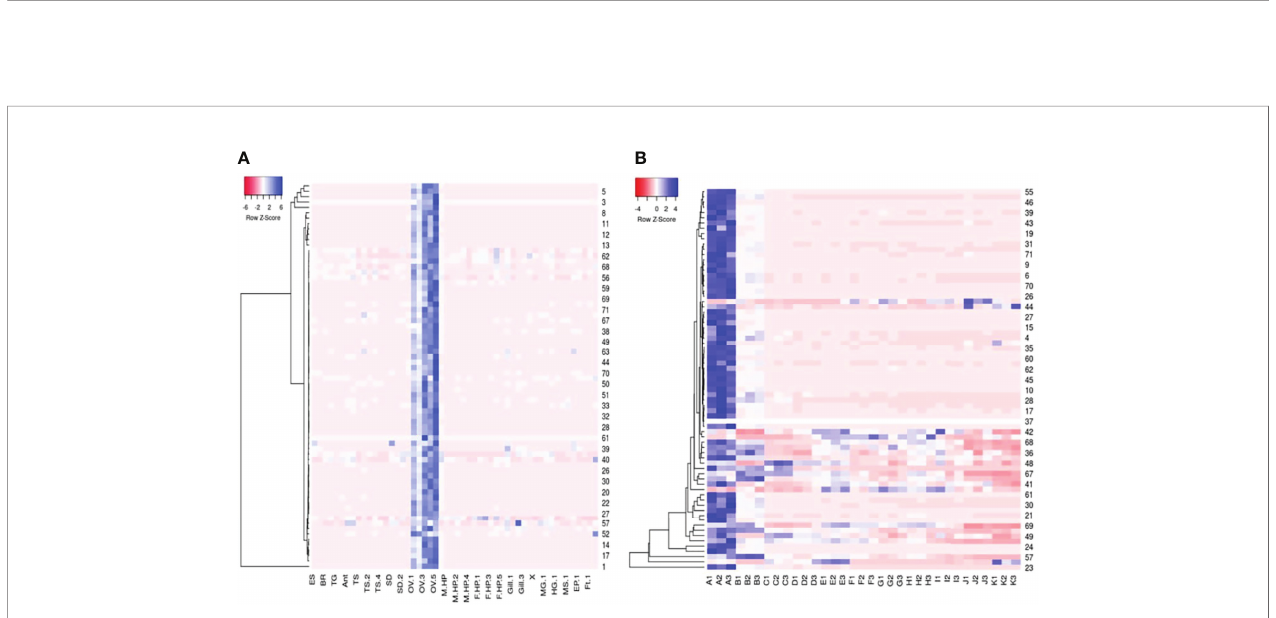
FIGURE 3 | Heatmaps of seventy-two Panulirus ornatus maternally-inherited transcripts identi fi ed in adult tissues (A) and 11 stages of embryonal development (B) made using Heatmapper (Babicki et al., 2016). The intensity of the transcript expression, represented as RPKM are displayed as colours ranging from red (lowest expression) to blue (highest expression). ES, eyestalk; BR, brain; TG, thoracic ganglia; Ant, antennal gland; TS, testes; SD, sperm duct; OV, ovary; M HP, male hepatopancreas, F HP, female hepatopancreas; MG, midgut (stomach); HG, hindgut (intestine); MS, muscle; EP, epidermis; Ft, fat (A) . The 11 P . ornatus embryonal stages from fertilization to hatch are represented in triplicates as follows; A – day 0, B – day 3, C – day 6, D – day 9, E – day 12, F – day 15, G – day 18, H – day 21, I – day 24, J – day 27, K – day 30.